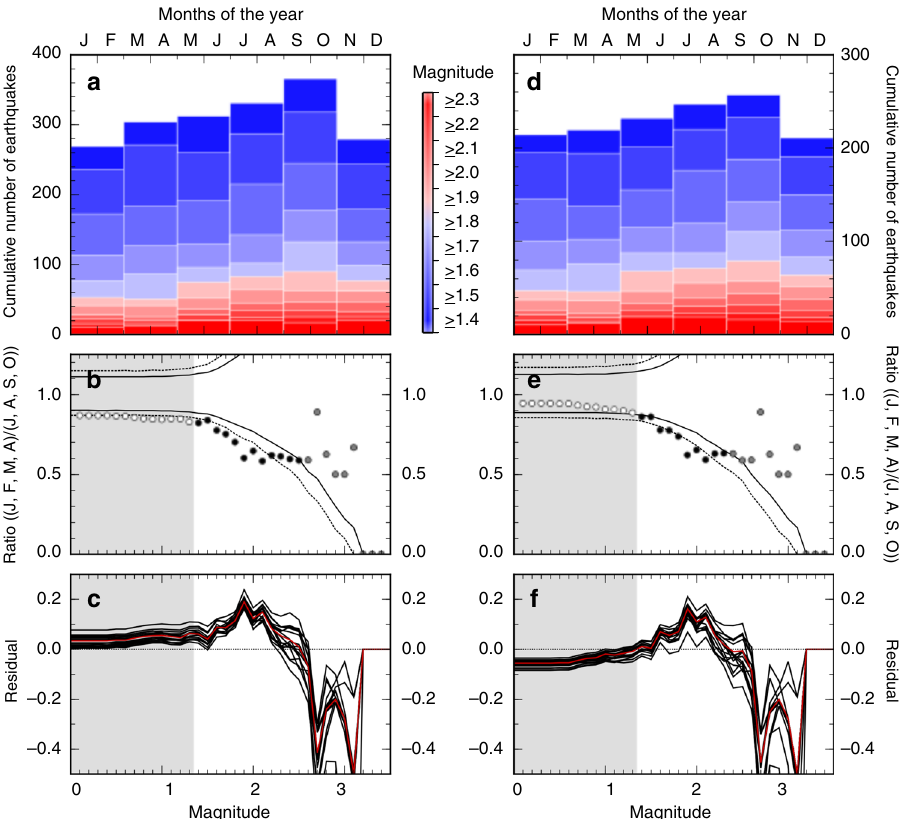
Fig. 4 Analysis of seasonal trends in seismicity around the Reelfoot Fault. a Histogram (in 2-month bins) for the number of earthquakes in the complete catalogue between 1 January 2000 and 31 December 2015 for the area around the Reelfoot fault, as shown in Fig. 1a by the red box. Colours are indicative of the magnitude cut-off used in each case. b Ratio of the number of earthquakes occurring in the 4-month period encompassing January, February, March, April, to those occurring in July, August, September, October as a function of cut-off magnitude. Grey shaded areas indicate the magnitude of completeness. Dashed and solid black lines indicate the 99 and 95% con fi dence limits, respectively. Black points are those where the ratio exceeds the 95% con fi dence limit. c results of a Jack-knife analysis of the seasonal trend. Lines indicate the residual at each magnitude band between the calculated ratio and the 95% con fi dence limit. Red line is for the full catalogue, as shown in b . Black lines are for the same catalogue with successive years of data removed. Con fi dence limits are estimated independently for each test. Grey area again indicates the magnitude of the completeness of the catalogue. d – f are as a – c , but for the seismicity catalogue after